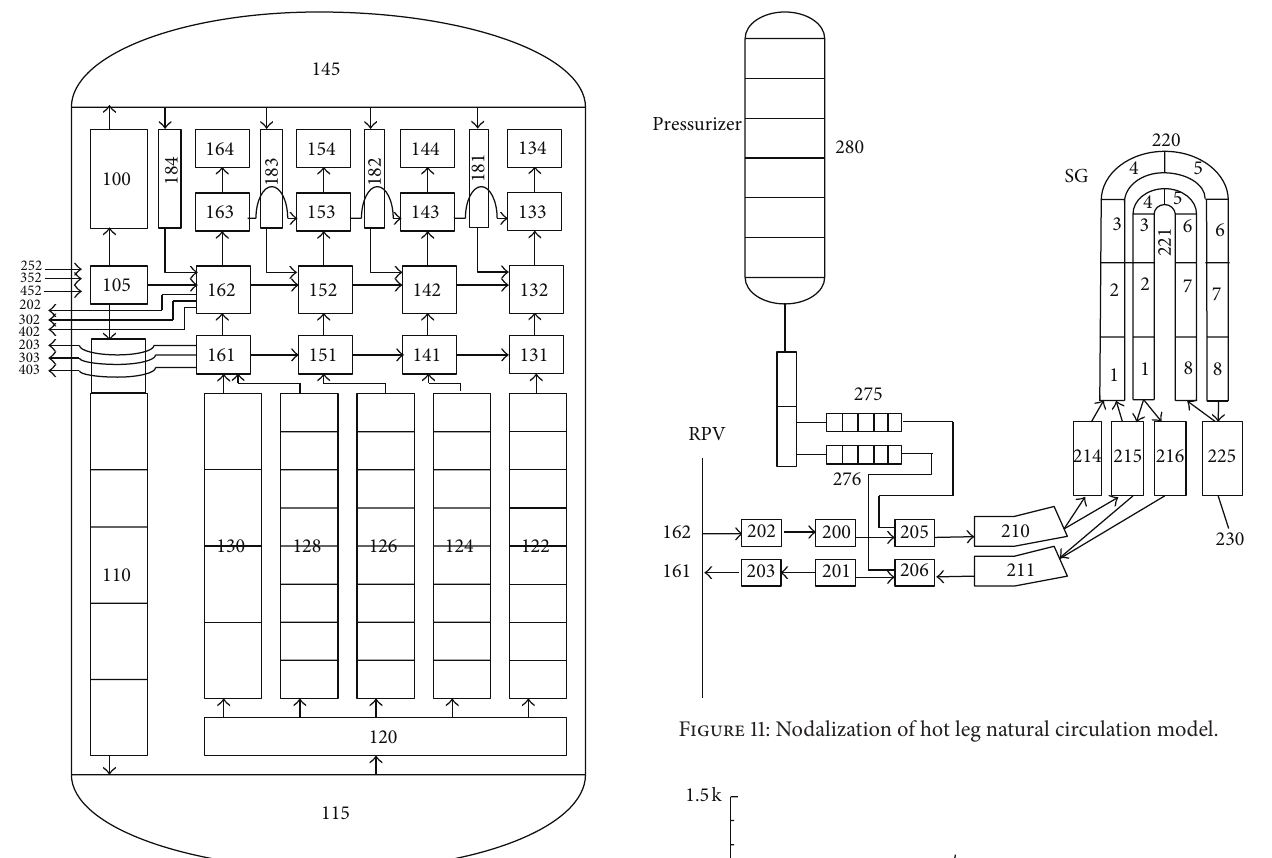
Figure 11: Nodalization of hot leg natural circulation model.